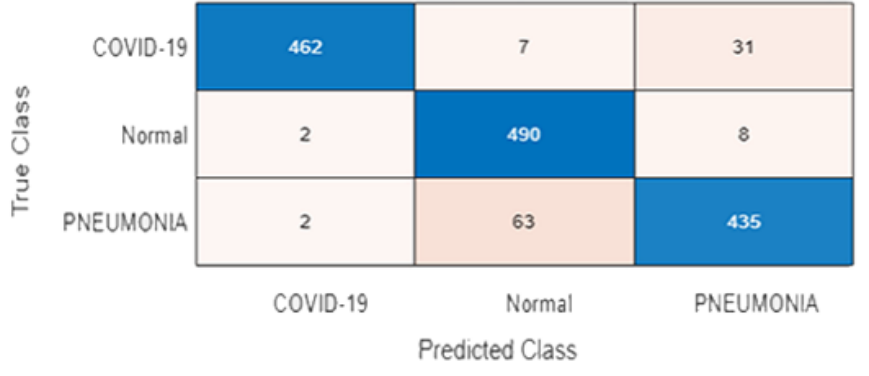
Figure 9. Confusion matrix of VGG16 based on TSTR.